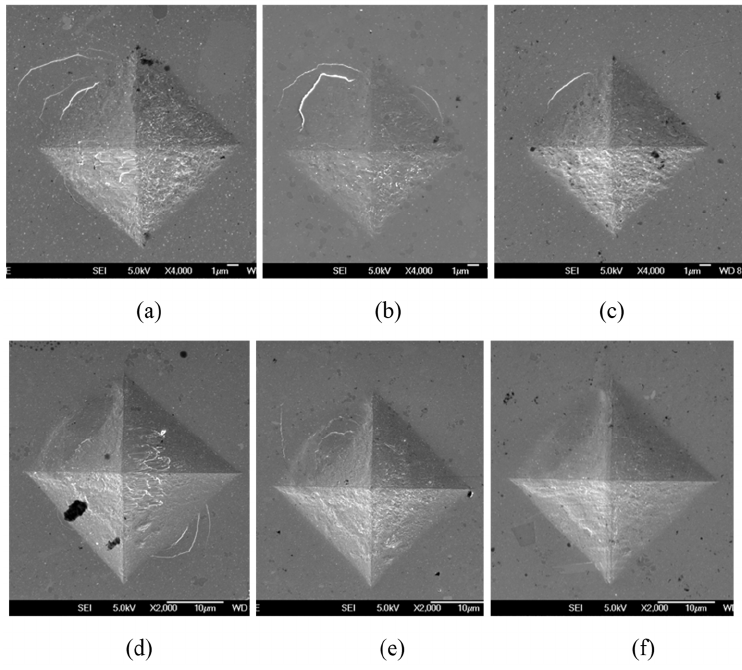
Figure 11. SEM images for the Vickers indents at 100 gf indent load on the material core of ( a ) Unt, ( b ) 350 ‐ 40 and ( c ) 380 ‐ 4.5; SEM images for the Vickers indents 500 gf indent load on the material core of ( d ) Unt, ( e ) 350 ‐ 40 and ( f ) 380 ‐ 4.5.